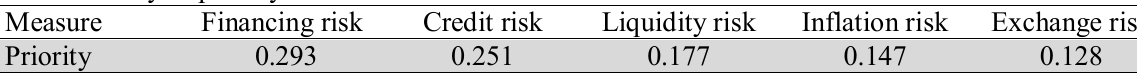
The summary of priority of the main five risk factors Measure